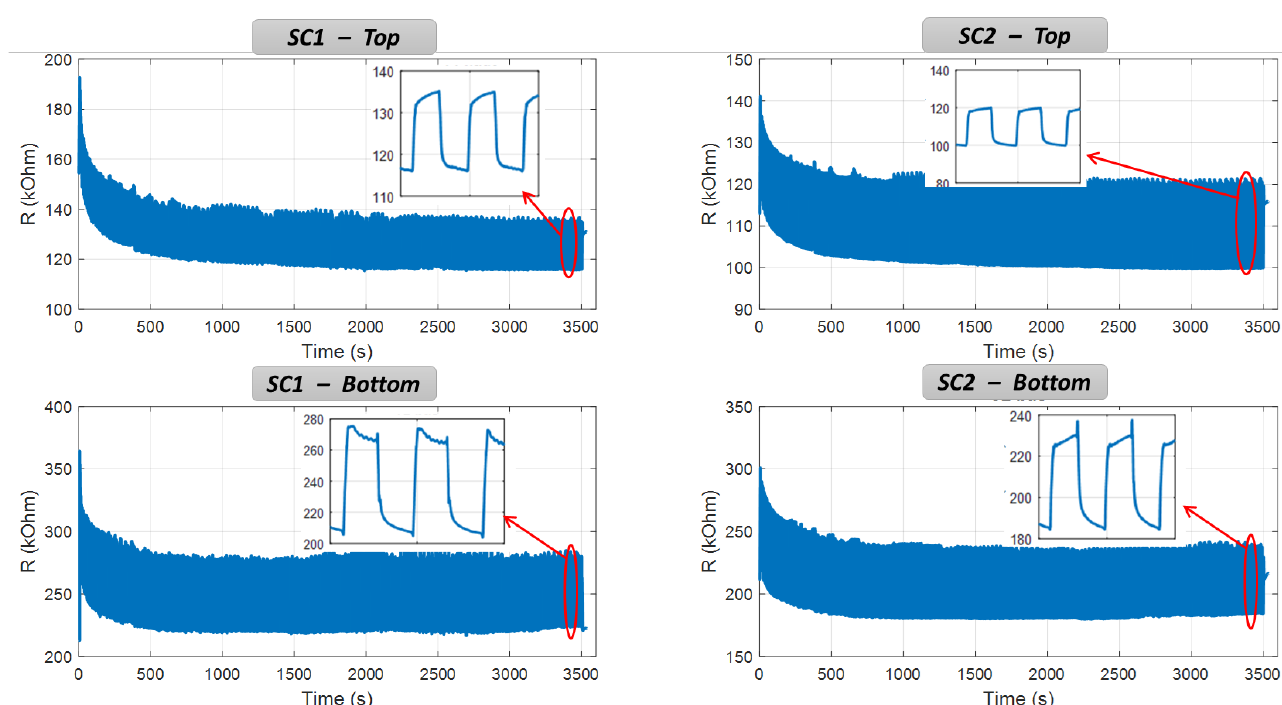
Figure 14. Aging test based on resistance measurement of the top and bottom coatings for SC1 and SC2. Inset graphs zoom in on the last portion of the curve for a short duration.